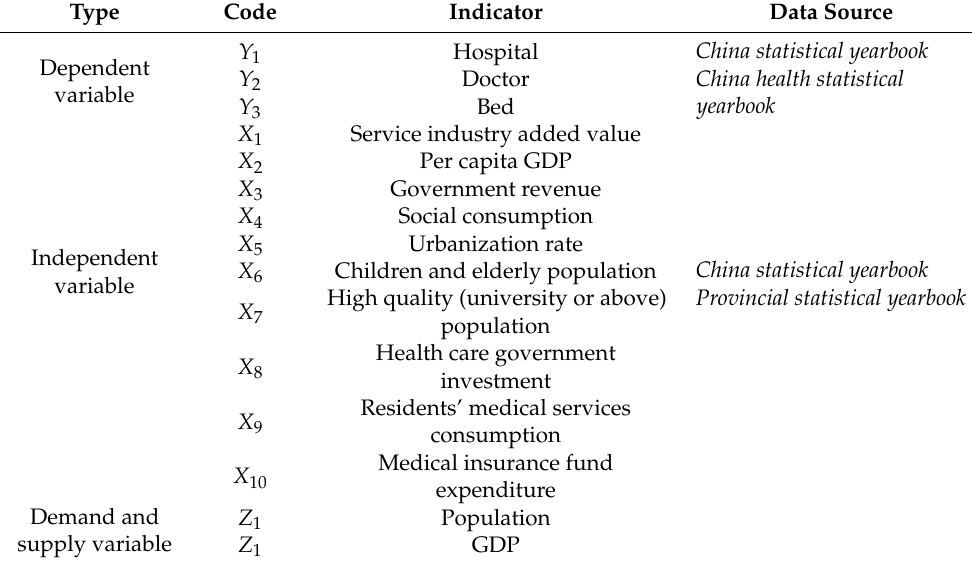
Table 1. Variables and data